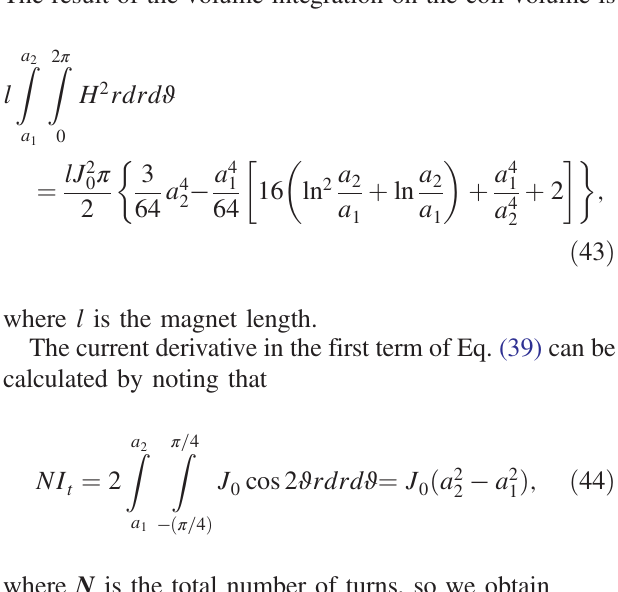
FIG. 1. Schematic quench protection